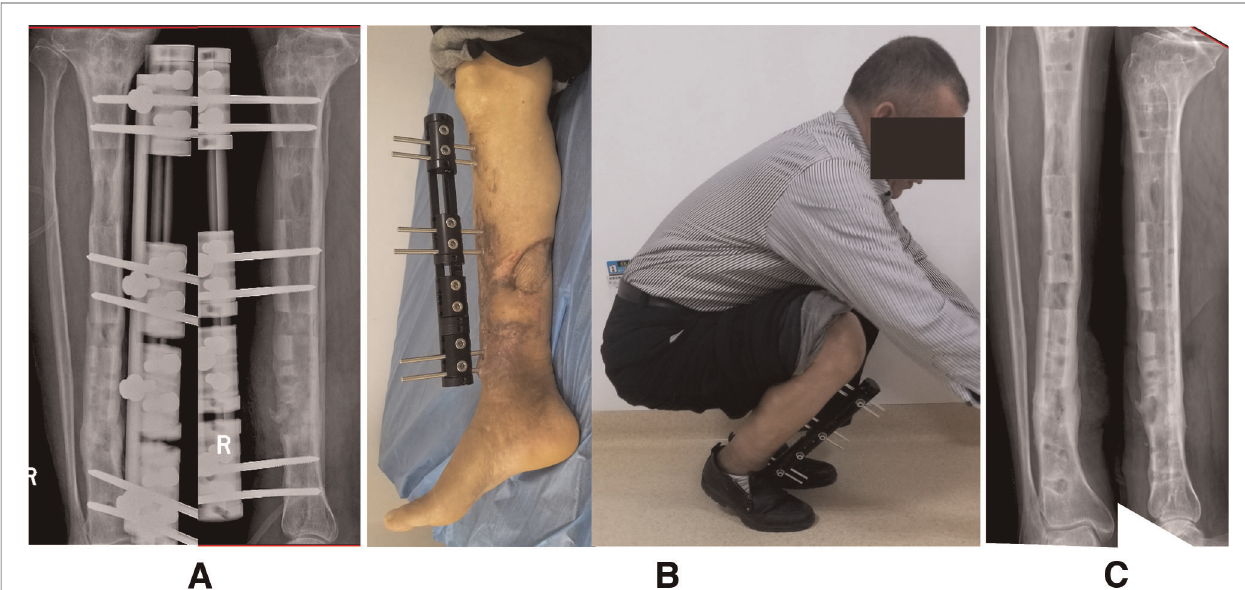
FIGURE 5 | Images of the same patient shown in Figure 4 . ( A ) Complete consolidation and docking site union after docking in 3 months. ( B ) Satisfactory functional recovery before monolateral external fi xator removal. ( C ) Radiographs 9 months later after removing the frame.